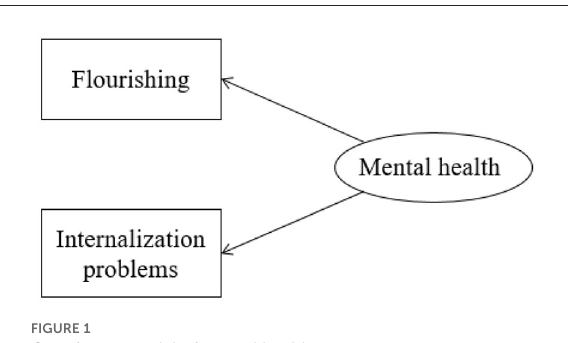
FIGURE1 One-factor model of mental health.